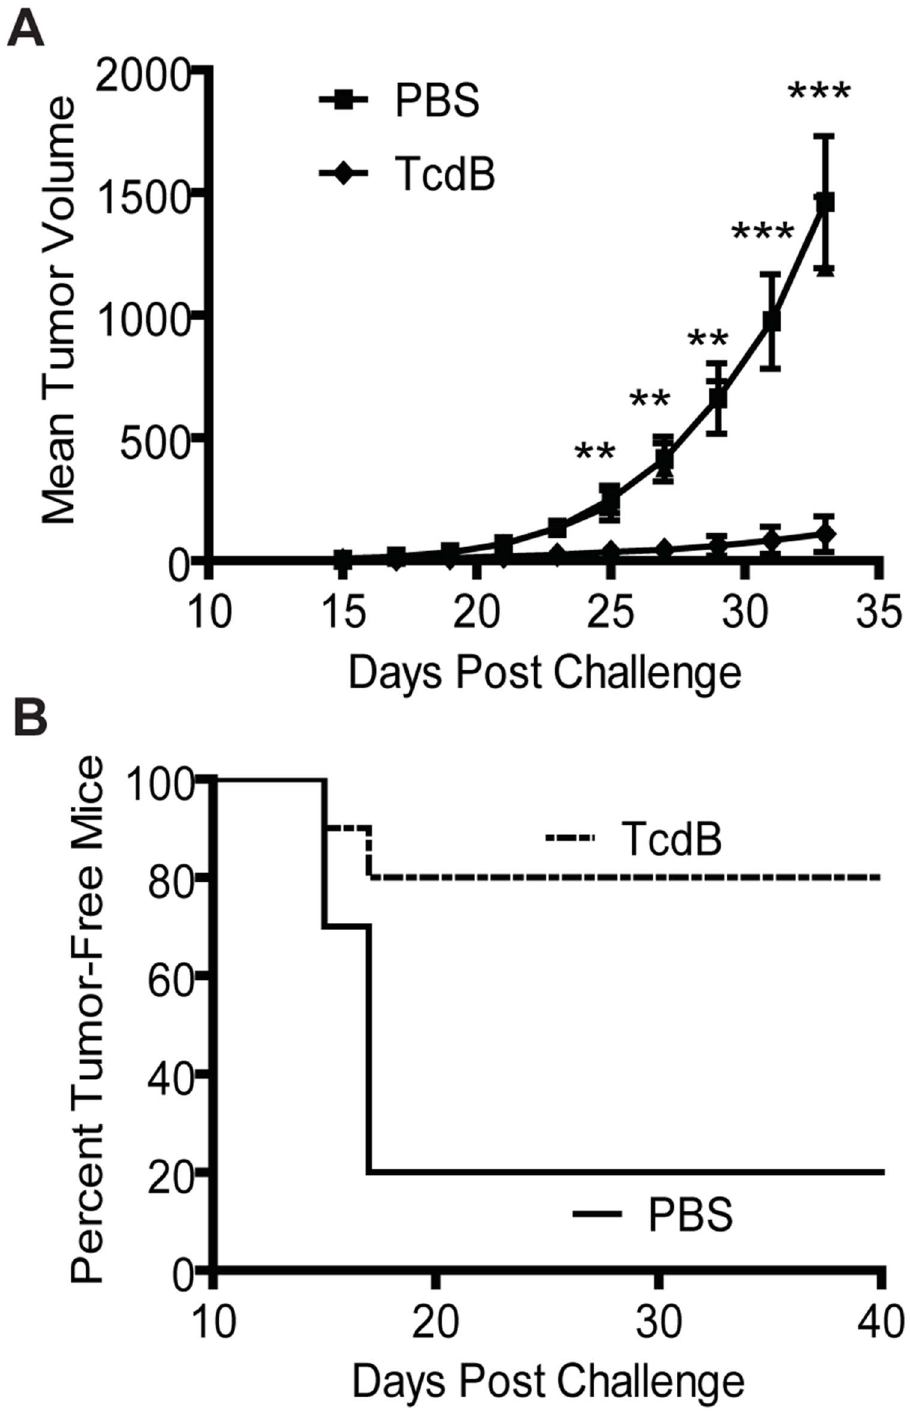
Figure 6. Induction of an anti-tumor immune response by TcdB-intoxicated B16-F10 cells. Mice were immunized once with PBS or 2 6 10 5 TcdB-exposed B16-F10 cells per mouse before challenge with lethal B16-F10 cells. Tumor volume (A) and the percentage of tumor-free mice (B) were measured. Representative data from one of three experiments are shown (n=10 for each experiment). **, P , 0.01 vs. PBS; ***, P , 0.001 vs. PBS (paired two-tailed t- test). Error bars,